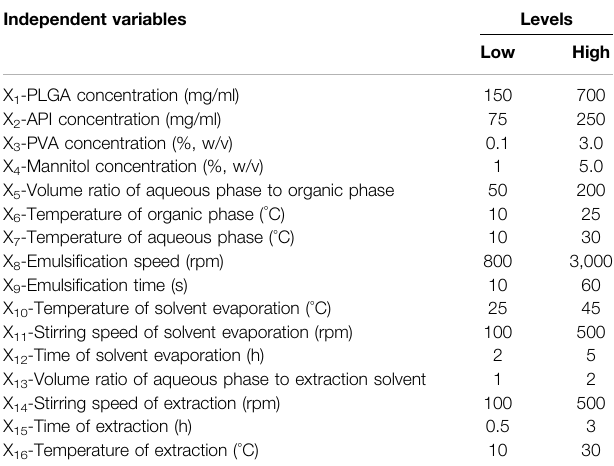
TABLE 1 | The independent variables and their levels in Plackett – Burman design. Independent